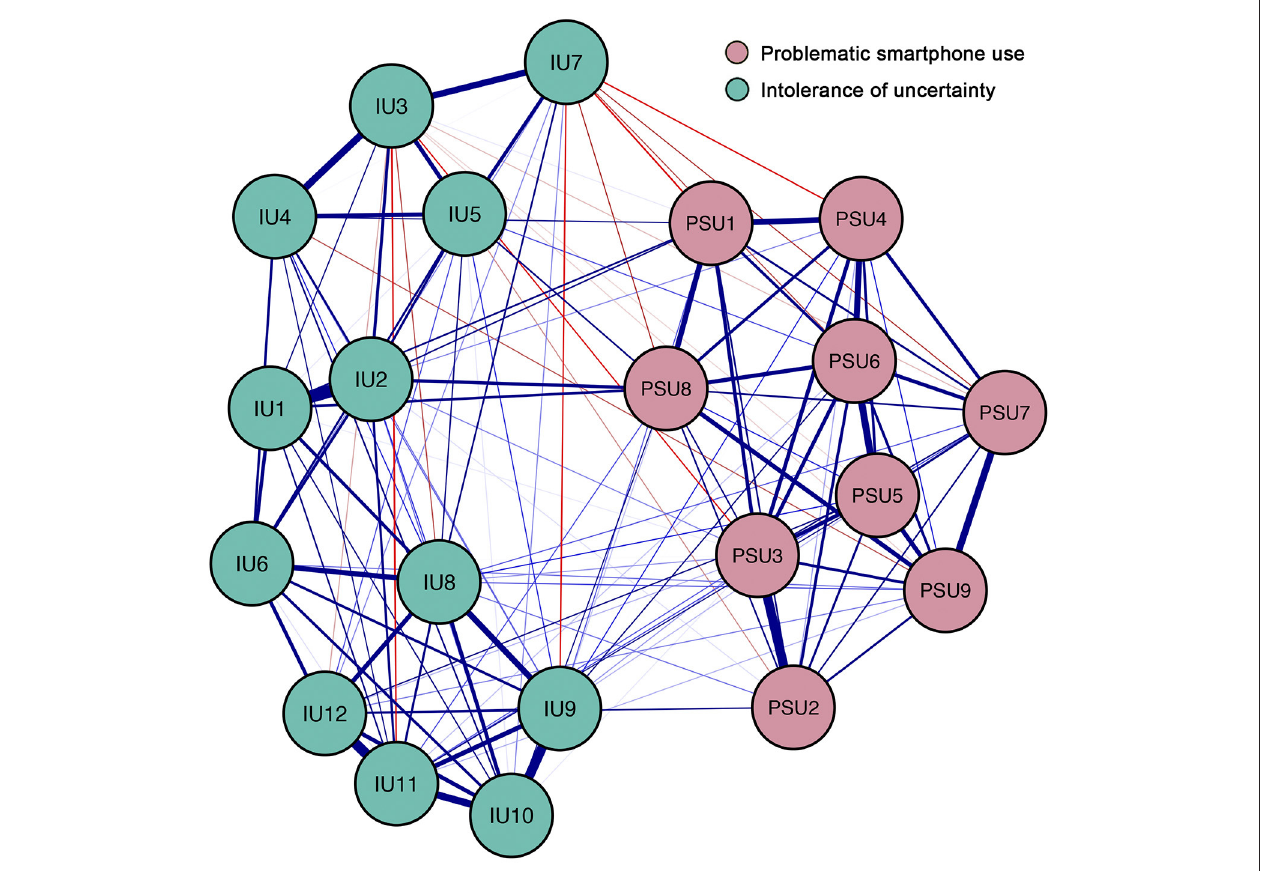
FIGURE 1 | Network structure of different components of intolerance of uncertainty and symptoms of problematic smartphone use. Blue edges represent positive correlations, red edges represent negative correlations. The thickness of the edge reflects the magnitude of the correlation. Cut value = 0.03. The text of variables selected in network can be seen in Table 1